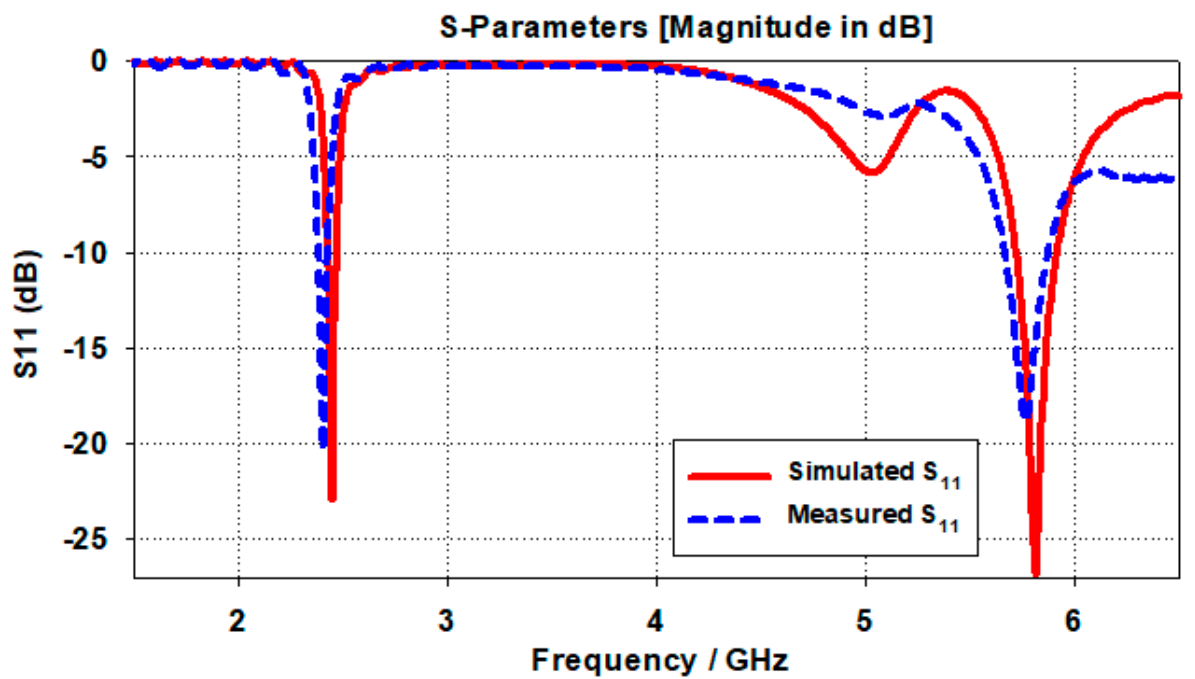
Figure 22. Fabricated prototype of the proposed antenna: ( a ) front view; ( b ) back view.